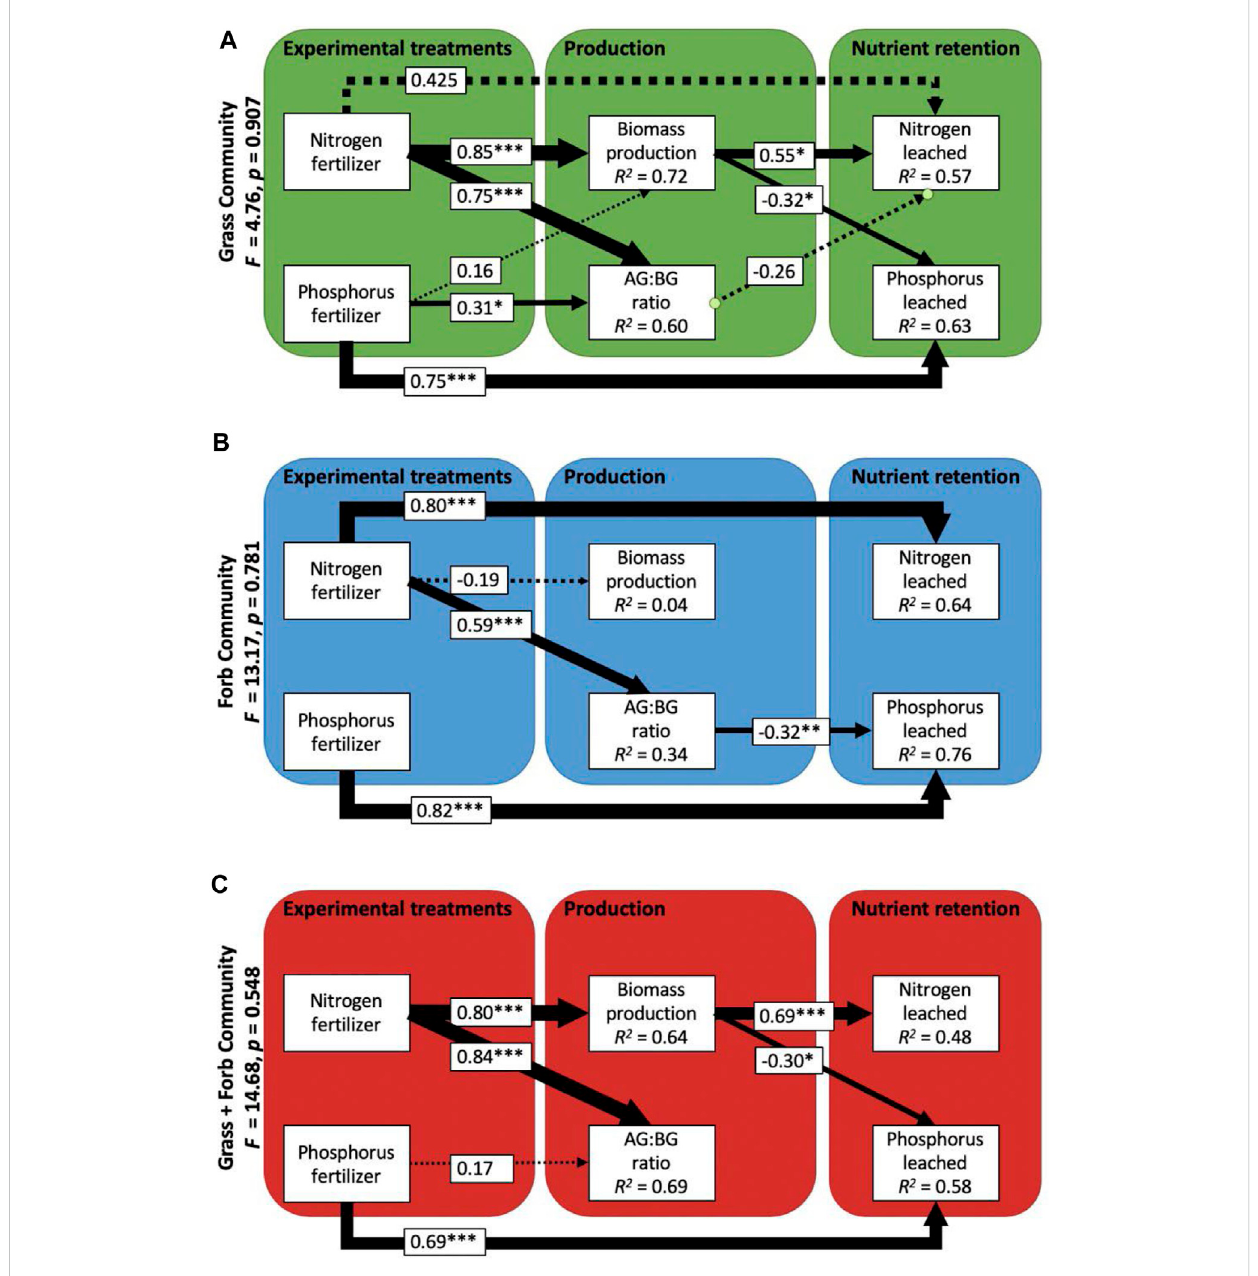
FIGURE 3 Best- fi t path models showing the links between experimental N and P additions, biomass production, ratios between above and belowground biomass (AG: BG), and amounts of N and P leached within the grass (A) , forb (B) and grass + forb (C) communities. Arrow thickness is proportional to the standardizedpathcoef fi cients, withthedirectionalityandsizegivenwithinboxesalongthearrow.Asterisksindicatesigni fi canceleveloflinkages(* < 0.05, ** < 0.01, *** < 0.001), and dashed lines are used when signi fi cance of paths is > 0.05. R2 values are given within the boxes containing endogenous